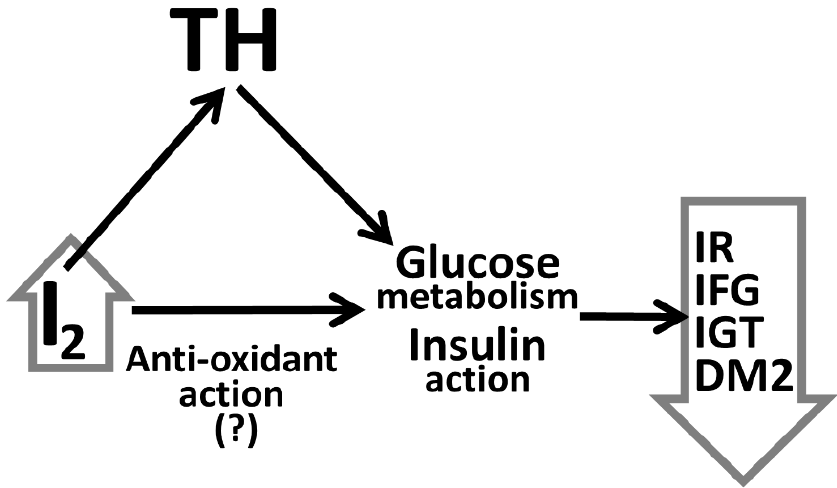
Figure 1. Tentative “triangular” aspect of Iodine’s (I 2 ) effects on glucose handling: indirect effects